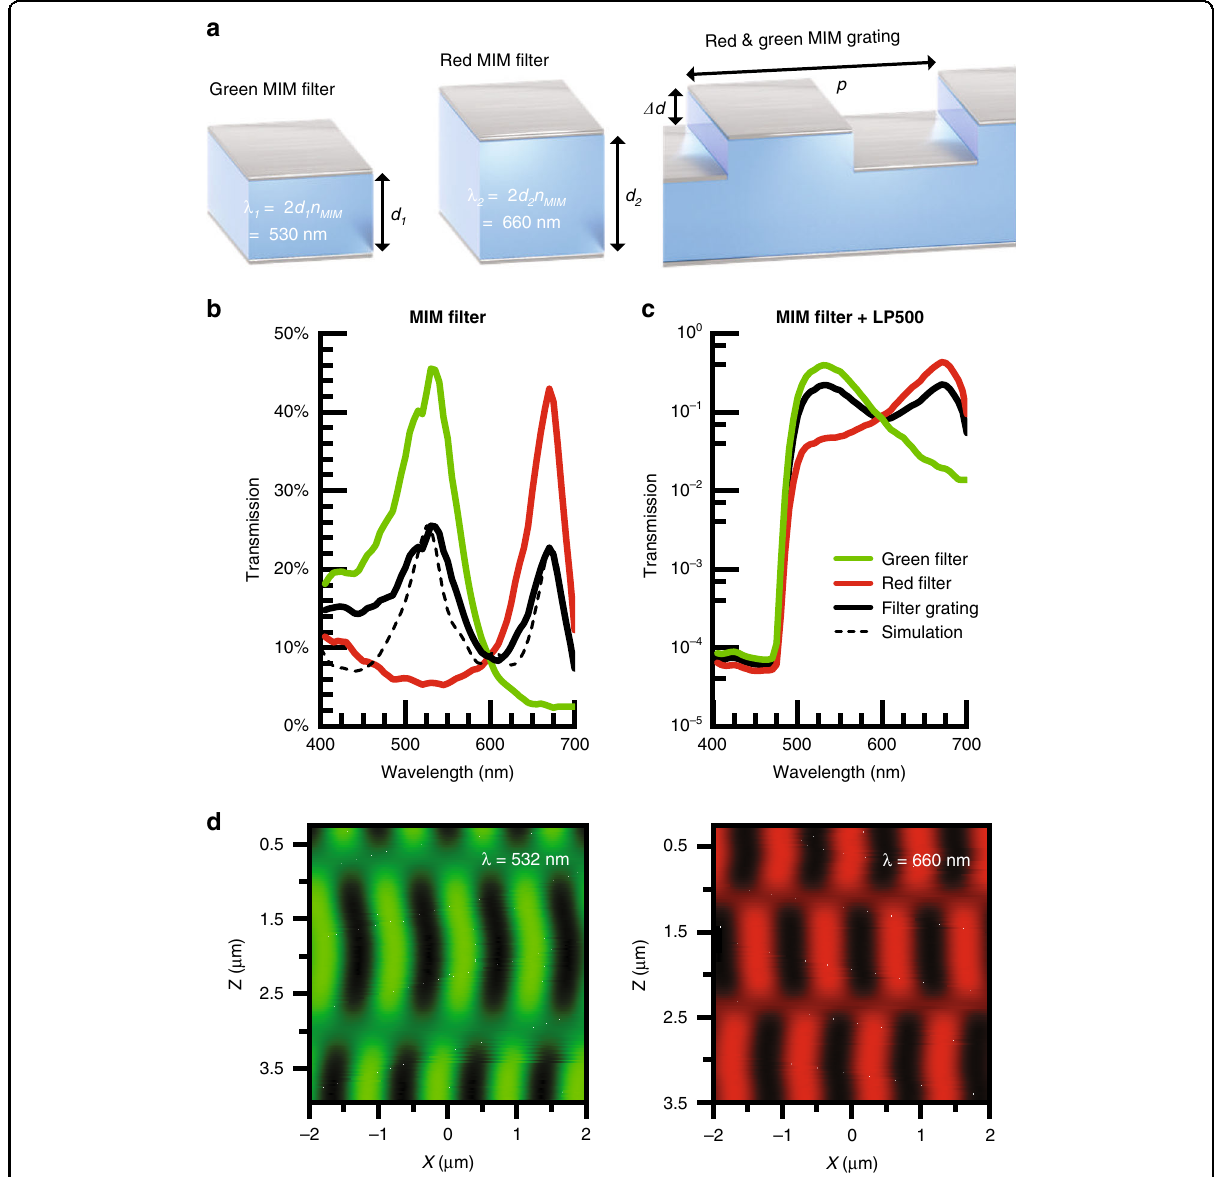
Fig. 1 MIMAS fi lter design. a The Ag-HfO2-Ag MIM spectral fi lter selectively transmits a single resonant wavelength by tuning the oxide thickness. Interleaving both color fi lters with wavelength scale pitch constructs the grating structure. b Transmission spectrum of planar bandpass fi lters and interleaved grating fi lter over the visible spectrum for measured (solid) and FDTD simulated (dash) devices. The planar bandpass fi lters selectively transmit a single color, whereas the interleaved structure transmits a superposition of the two. c A 500 nm cut-on longpass fi lter dye is combined with the MIM fi lter, attenuating wavelengths under 480 nm by four orders of magnitude. d Veri fi cation of non-overlapping microscale Talbot self- image using near- fi eld scanning optical microscopy (NSOM) in transmission mode, at wavelengths of 532 and 660